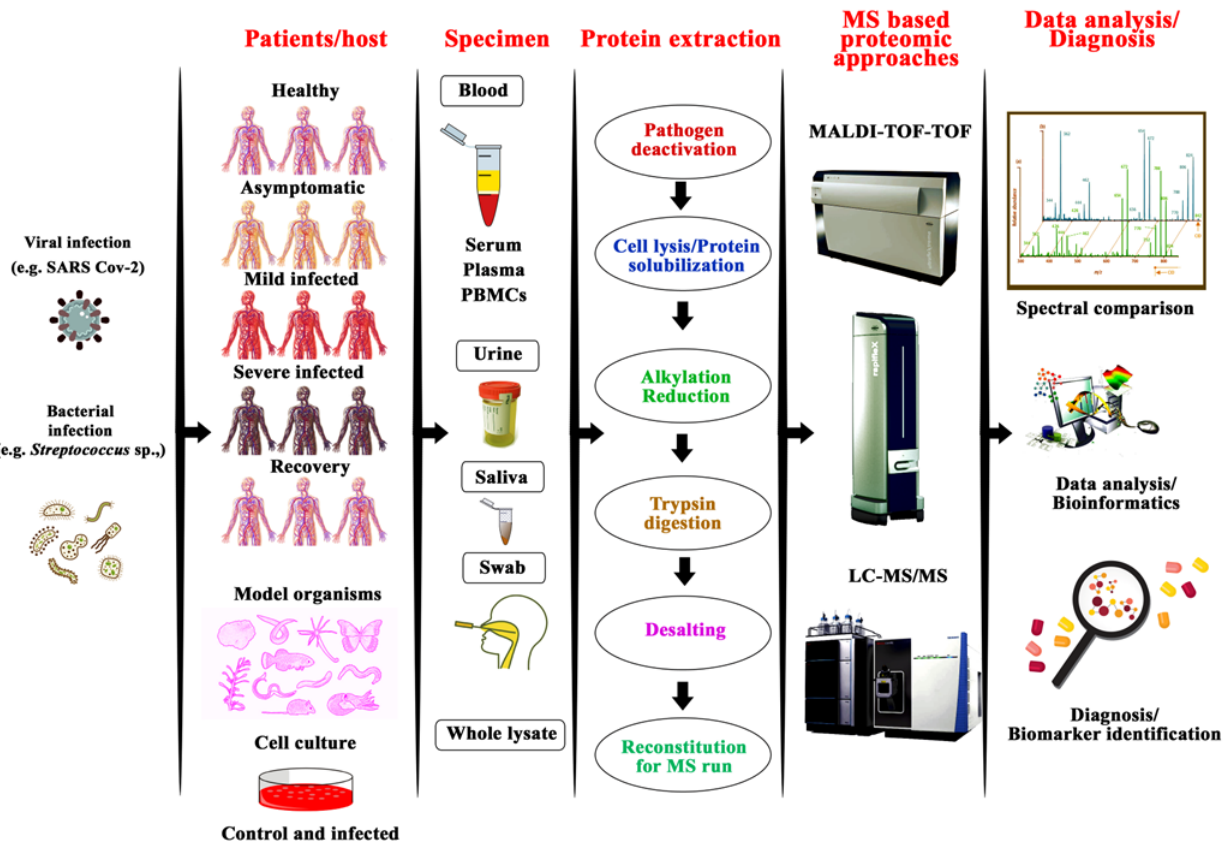
Figure 2. Overall methodologies for mass spectrometry methods for microbial identification and disease diagnosis.